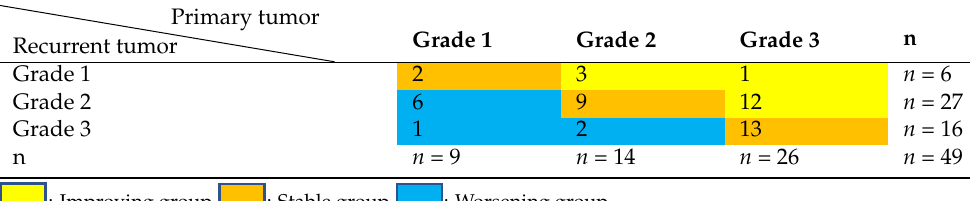
Table 1. Distribution of grade changes.